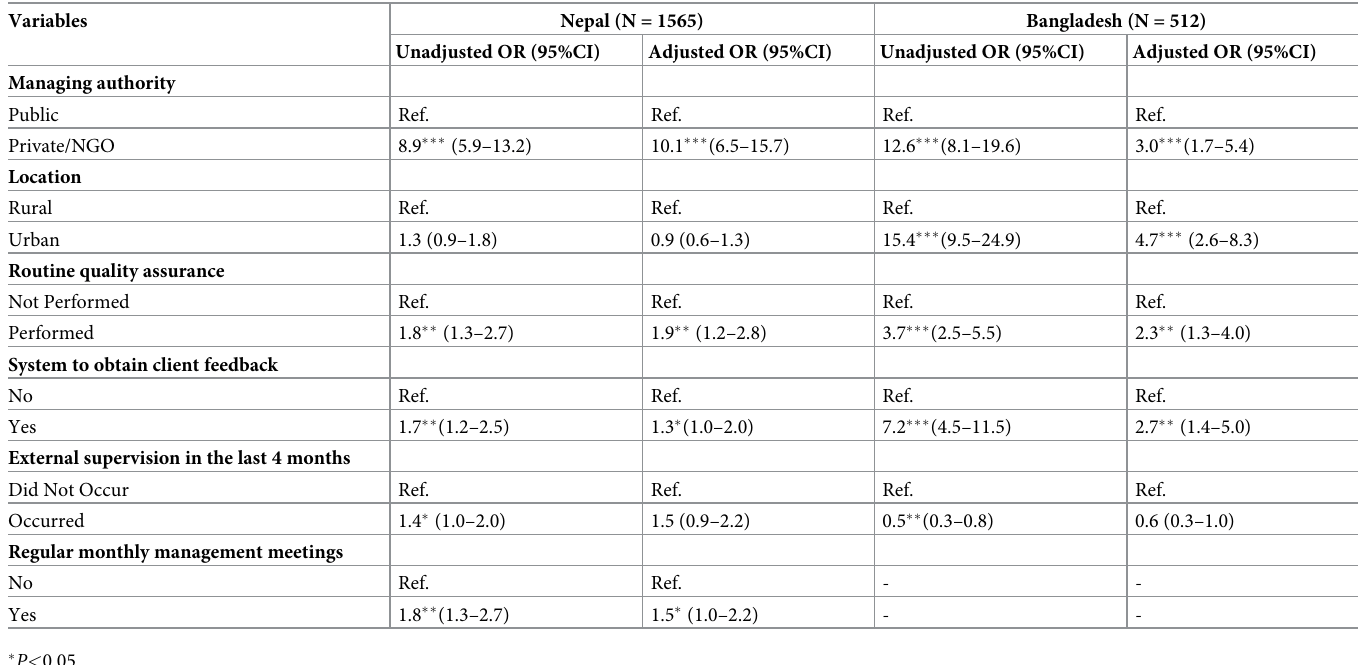
Table 6. Factors associated with readiness for providing both ANC and NCD services (binary logistic regression estimating